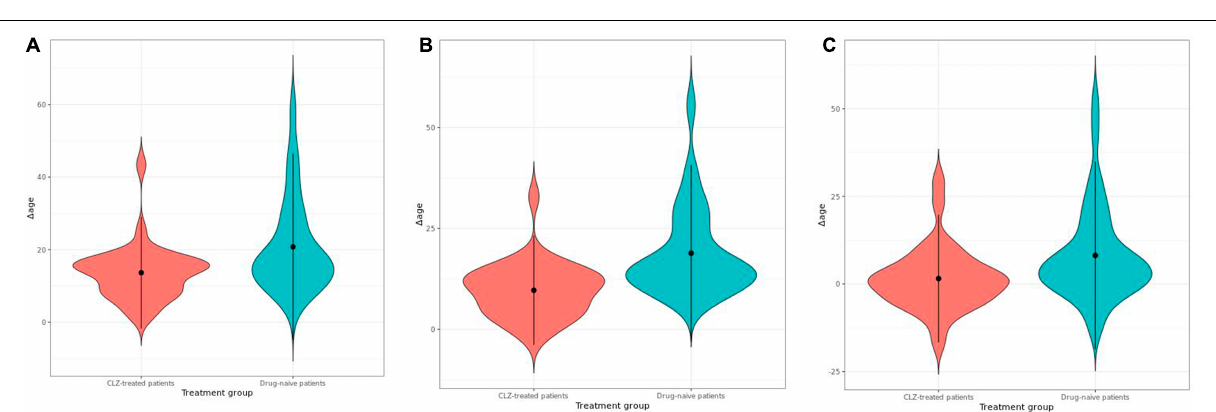
Frontiers in Psychiatry |